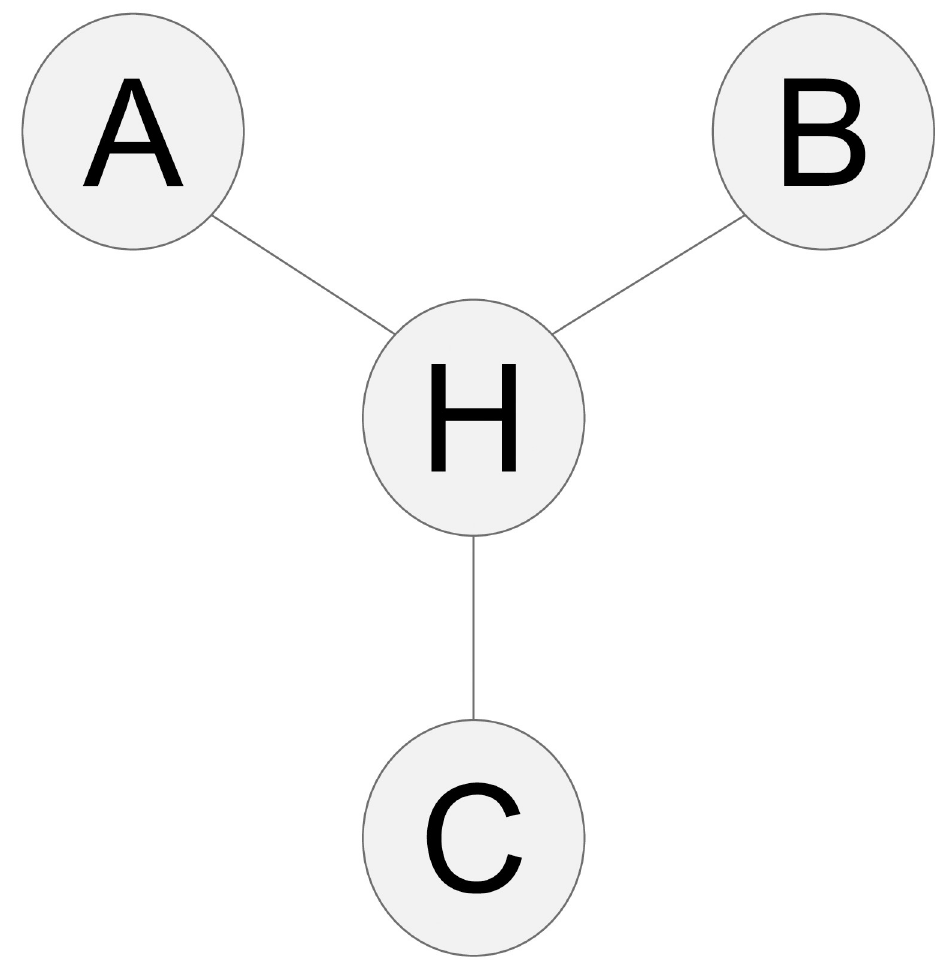
Fig 1. Essential graph G of variables A, B, C, and H. H is an undirected hub connecting the other three variables.